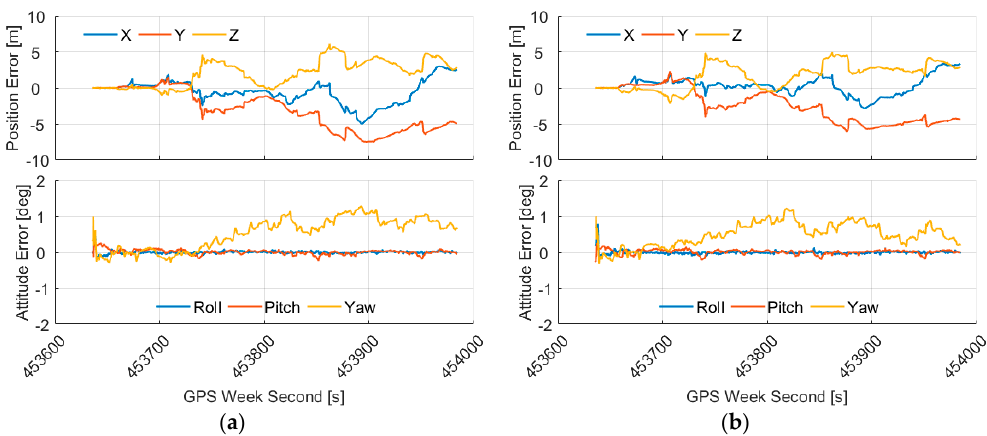
Figure 7. The RMSEs of the MTi-G-710 under 0-degree geodetic displacement for the sequence WRIC: ( a ) The RMSEs for Setting A, and ( b ) the RMSEs for Setting C.